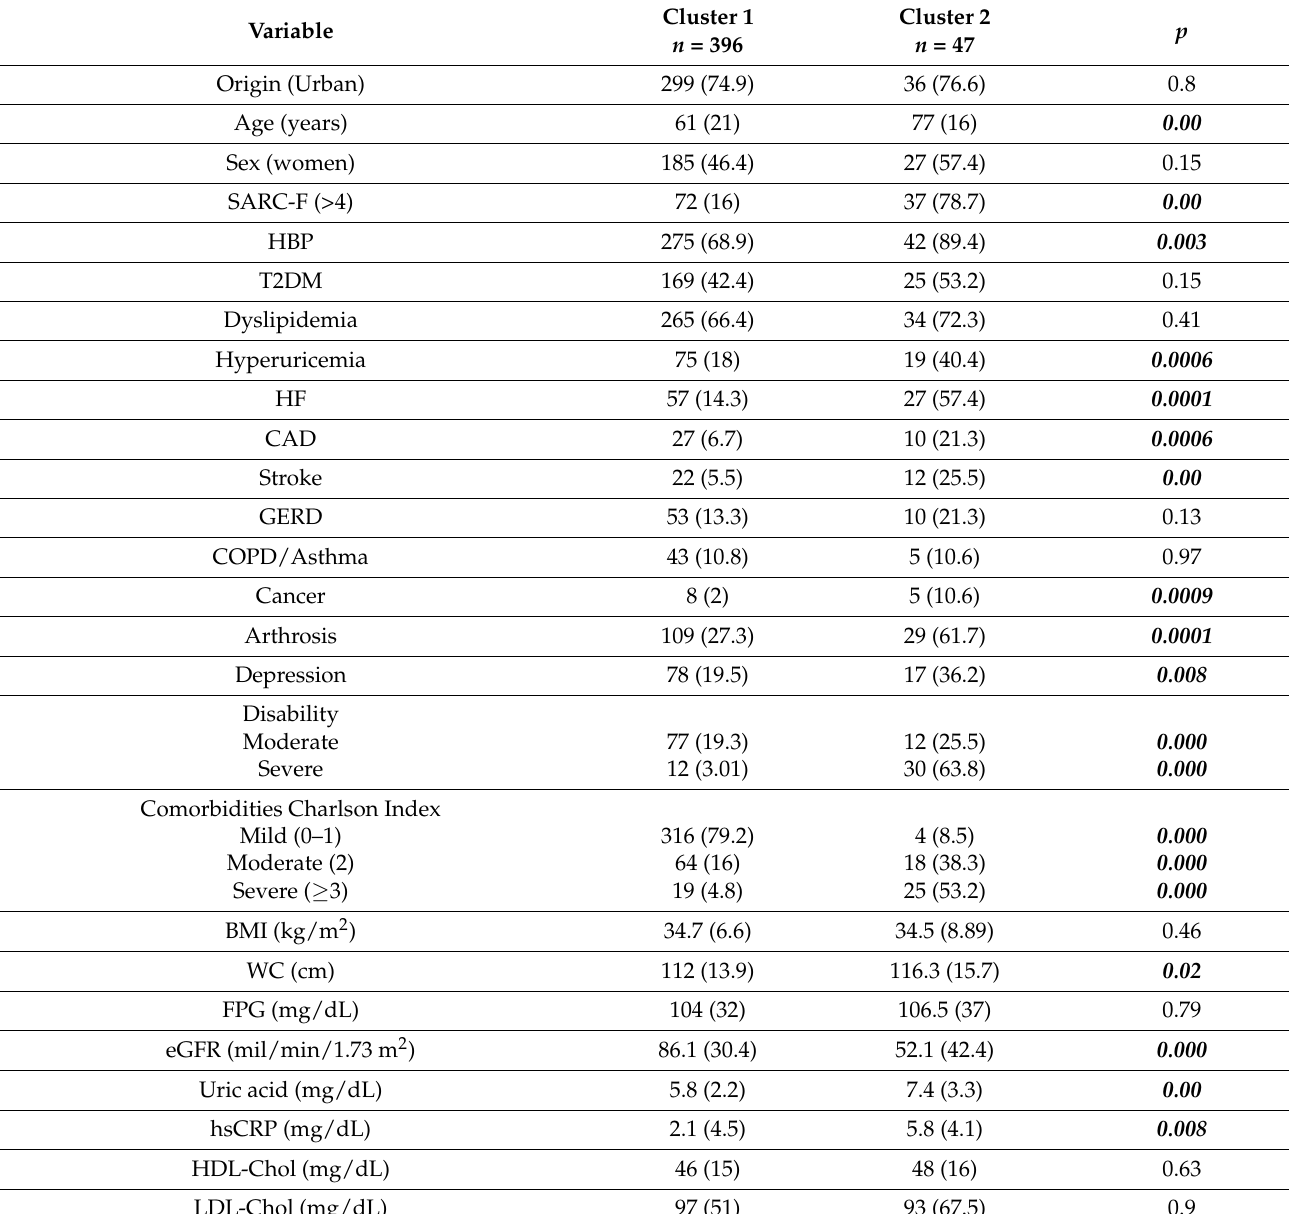
Table 3. Cluster Analysis in high-risks